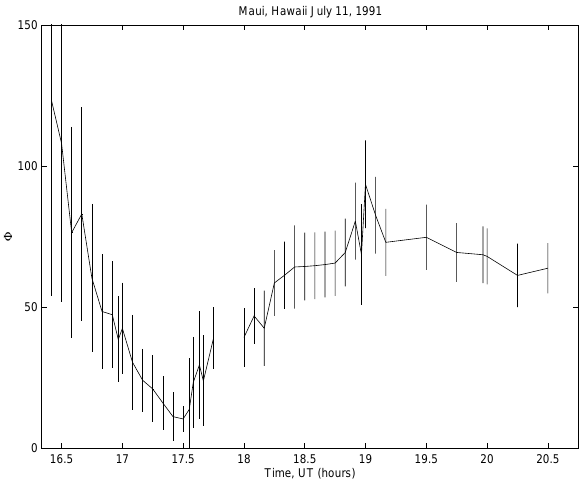
Fig. A8. The variation of 8 during the eclipse of 11 July 1991 at Maui, Hawaii as calculated using Eq. (2) using the data shown in Fig.